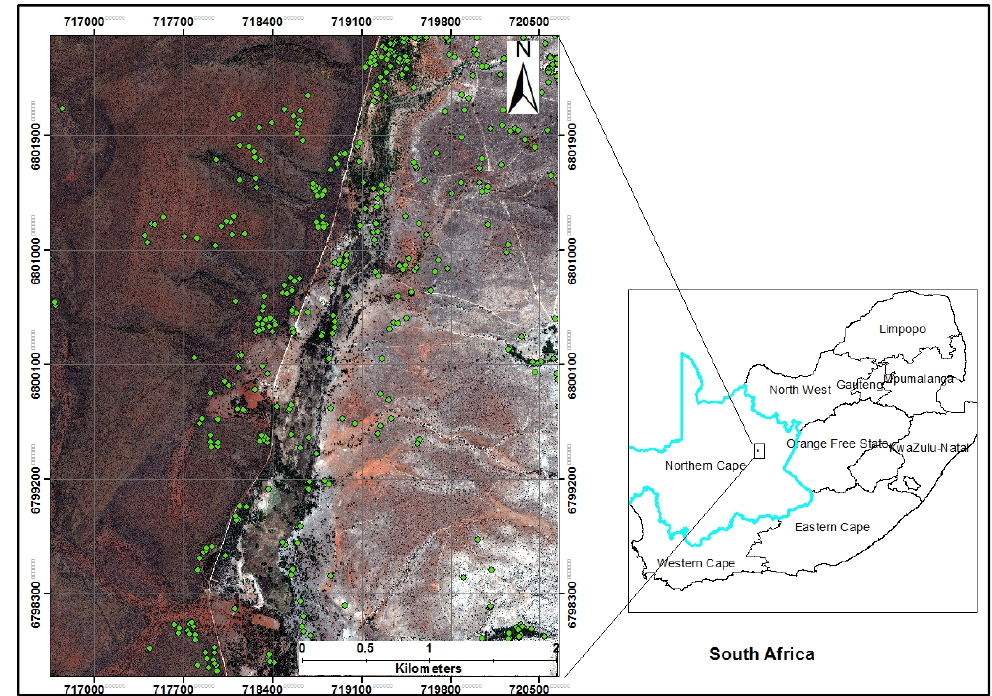
Figure 1. A true-color composite WorldView2 image showing the location of the study area and some of the field samples.